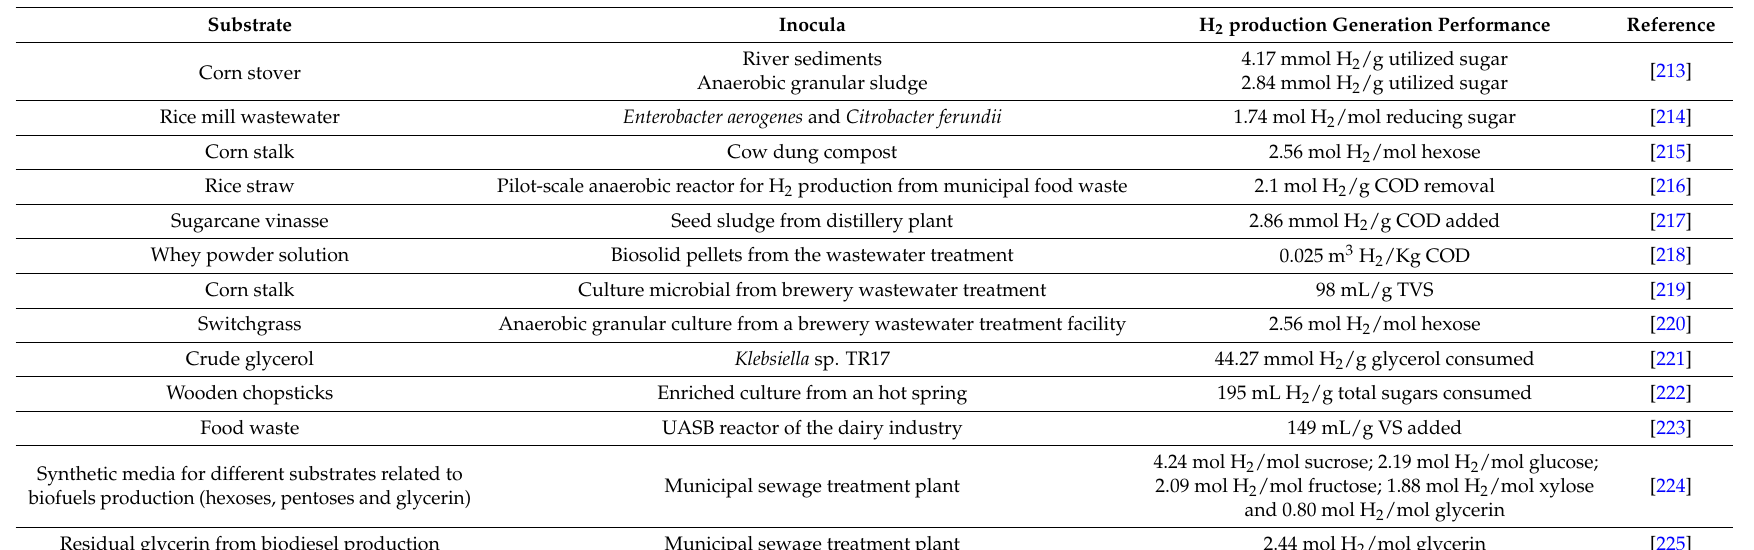
Table 6. Hydrogen production by anaerobic fermentation from waste